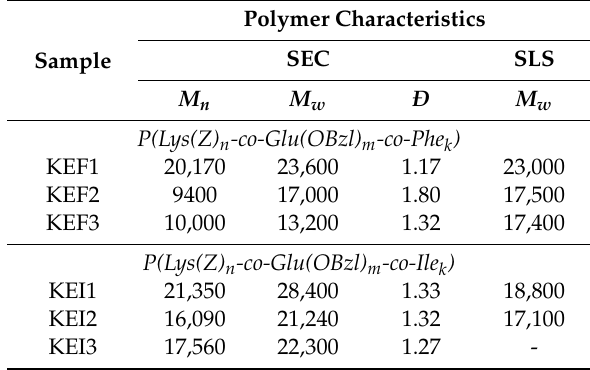
Table 1. Molecular-weight characteristics of protected polypeptides determined by SEC and SLS.